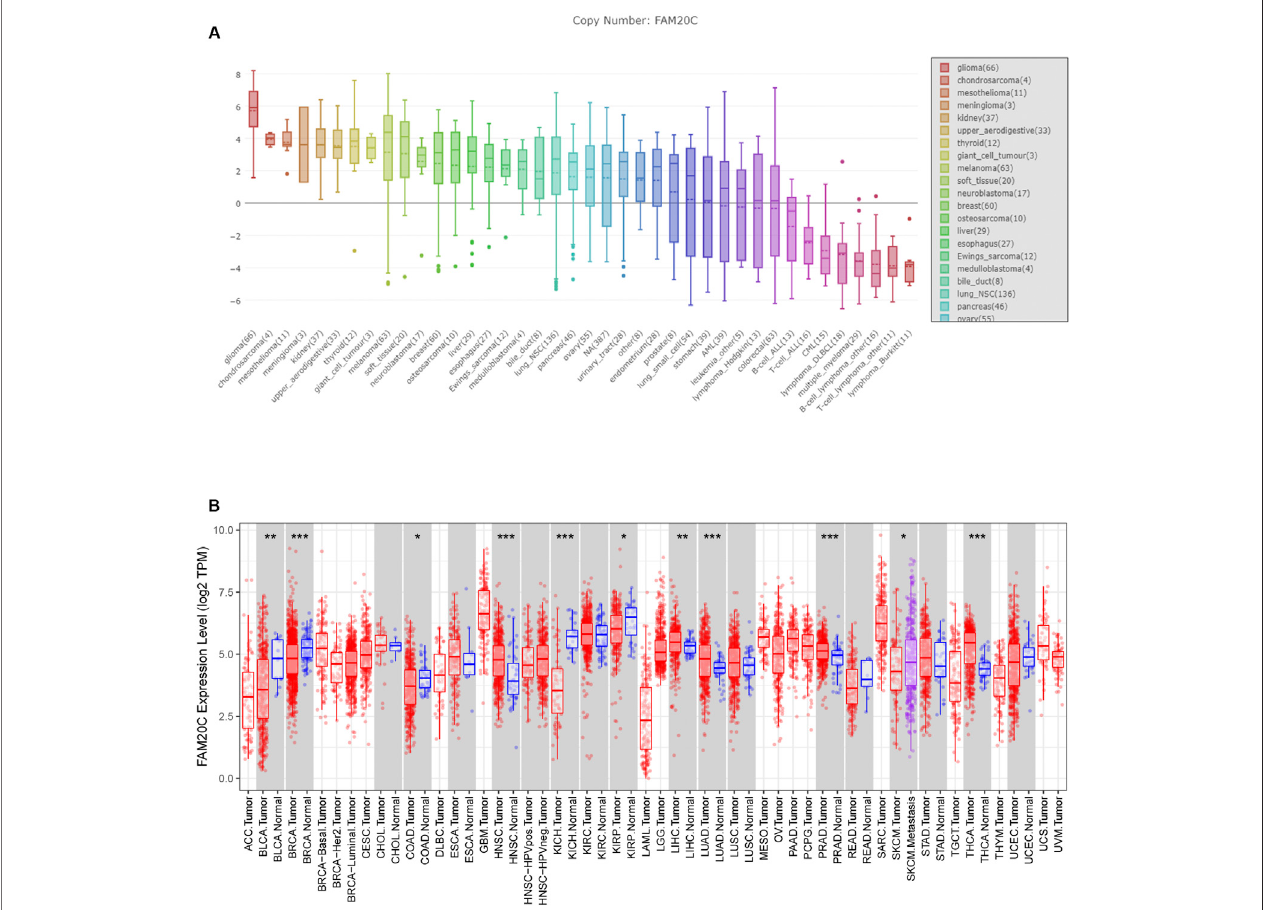
FIGURE1| Theexpression ofFAM20C indifferenttypes ofcancer,including glioma. (A) Theexpression ofFAM20C indifferenttypes ofcancercellswasobtained from the CCLE database, including glioma ( n (cid:1) 66), chondrosarcoma ( n (cid:1) 4), mesothelioma ( n (cid:1) 11), meningioma ( n (cid:1) 3), kidney ( n (cid:1) 37), upper aerodigestive ( n (cid:1) 33), thyroid( n (cid:1) 12),giantcelltumour( n (cid:1) 3),melanoma ( n (cid:1) 63),softtissue( n (cid:1) 20),neuroblastoma( n (cid:1) 17),breast( n (cid:1) 60),osteosarcoma( n (cid:1) 10),liver( n (cid:1) 29),esophagus ( n (cid:1) 27), Ewing ’ s sarcoma (n (cid:1) 12), medulloblastoma ( n (cid:1) 4), bile duct ( n (cid:1) 8), lung NSC ( n (cid:1) 136), pancreas ( n (cid:1) 46), ovary ( n (cid:1) 55), urinary tract ( n (cid:1) 28), endometrium ( n (cid:1) 28), prostate ( n (cid:1) 8), lung small cell ( n (cid:1) 54), stomach ( n (cid:1) 39), acute myeloid leukemia ( n (cid:1) 39), leukemia other ( n (cid:1) 5), lymphoma Hodgkin ( n (cid:1) 13), colorectal( n (cid:1) 63), B cell acute lymphoblastic leukemia ( n (cid:1) 13), Tcell acute lymphoblastic leukemia ( n (cid:1) 16), chronic myelogenous leukemia ( n (cid:1) 15), lymphoma DLBCL ( n (cid:1) 18), multiple myeloma ( n (cid:1) 29), B cell lymphoma other ( n (cid:1) 16), T cell lymphoma other ( n (cid:1) 11), and lymphoma Burkitt ( n (cid:1) 11); (B) the expression of FAM20C in different types of cancer was obtained from Tumor Immune Estimation Resource database, including ACC ( n (cid:1) 77), BLCA ( n (cid:1) 423), BRCA ( n (cid:1) 1197), CESC ( n (cid:1) 309), CHOL ( n (cid:1) 45), COAD ( n (cid:1) 316), DLBC ( n (cid:1) 47), ESCA ( n (cid:1) 195), GBM ( n (cid:1) 163), HNSC ( n (cid:1) 563), KICH ( n (cid:1) 91), KIRC ( n (cid:1) 595), KIRP ( n (cid:1) 318), LAML ( n (cid:1) 173), brain LGG ( n (cid:1) 518), LIHC ( n (cid:1) 419), LUAD ( n (cid:1) 542), LUSC ( n (cid:1) 542), MESO ( n (cid:1) 87), OV ( n (cid:1) 426), PAAD ( n (cid:1) 183), PCPG ( n (cid:1) 185), PRAD ( n (cid:1) 544), READ ( n (cid:1) 102), SARC ( n (cid:1) 264), SKCM ( n (cid:1) 462), STAD ( n (cid:1) 444), TGCT ( n (cid:1) 137), THCA ( n (cid:1) 571), THYM ( n (cid:1) 120), UCEC ( n (cid:1) 187), UCS ( n (cid:1) 57), and UVM ( n (cid:1) 79). * p < 0.05; *** p <